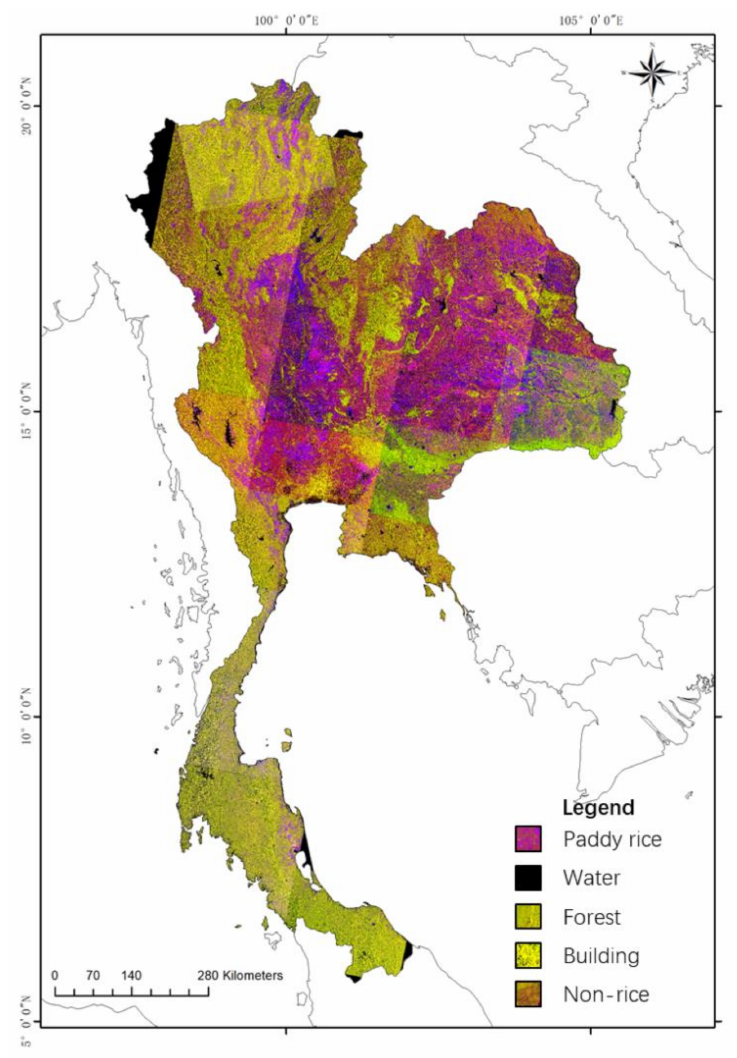
Figure 11. The mosaicked false-color image of temporal features in